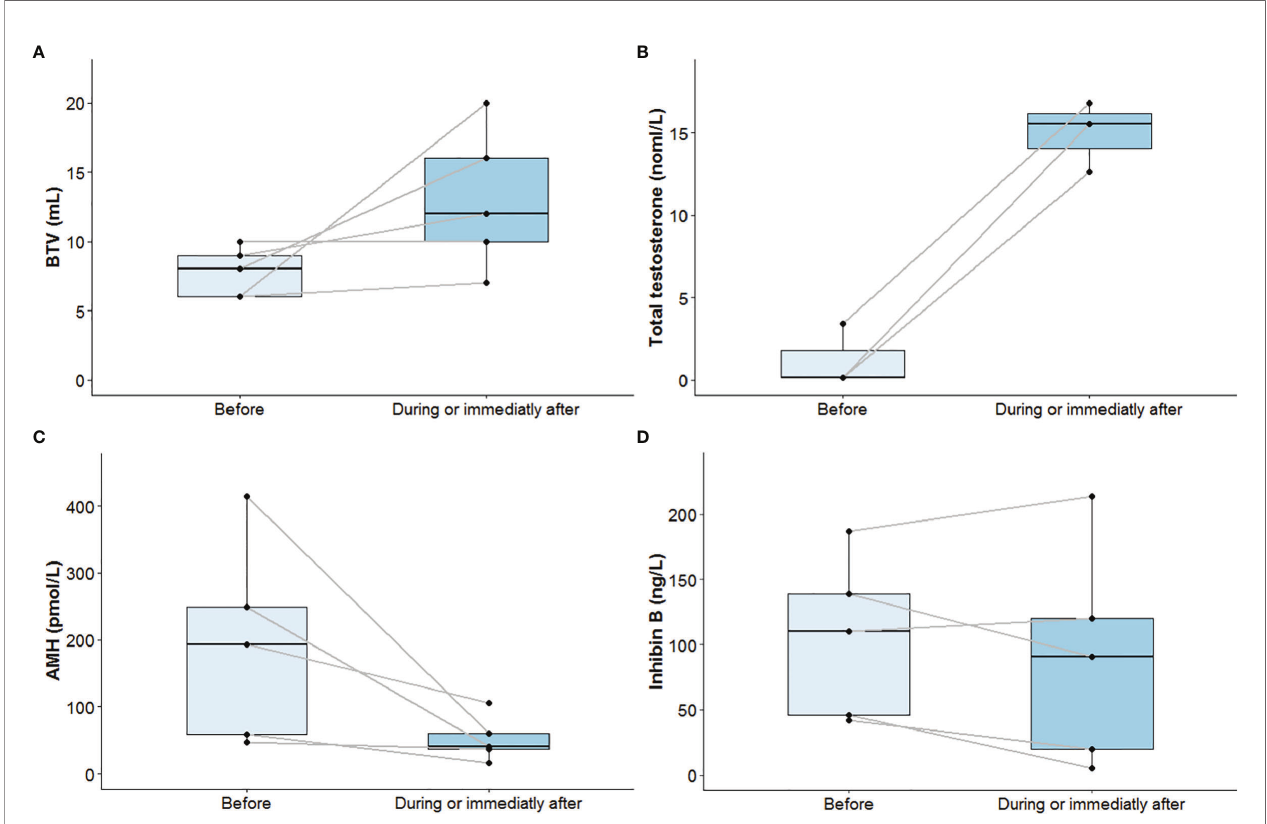
FIGURE 3 | Bi-testicular volume (A) , plasma total testosterone (B) , serum AMH (C) , and serum inhibin B (D) progression before and during or immediately after termination of gonadotropin treatment. Median values and interquartile ranges are presented in two boxplots for each parameter: one for values measured before initiation of gonadotropin treatment and one for values measured during or immediately after termination. Each black dot corresponds to one patient. Black dots obtained from the same patient before and during or immediately after termination of gonadotropin treatment are connected by solid gray lines. For plasma total testosterone, only patients with values before and during or immediately after termination of gonadotropin treatment were considered. An increase in BTV and total testosterone levels and a decrease in AMH levels after at least 12 months under gonadotropin treatment is observed. Variation in inhibin B levels is not as clear. AMH, anti-Müllerian hormone; BTV, bi-testicular